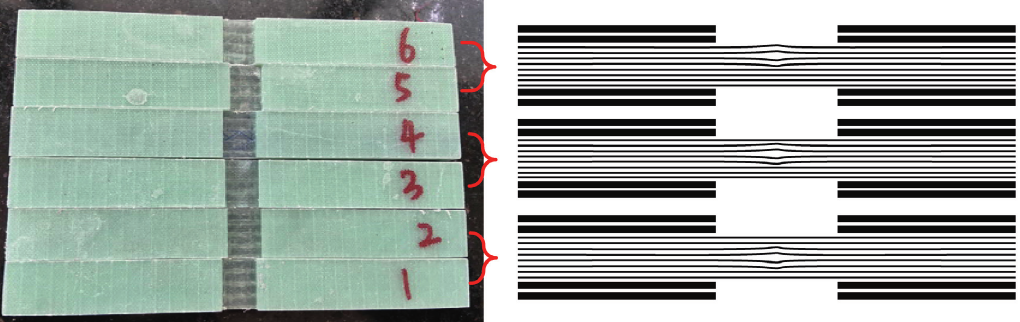
Figure 9: Specimens for the coupon test.